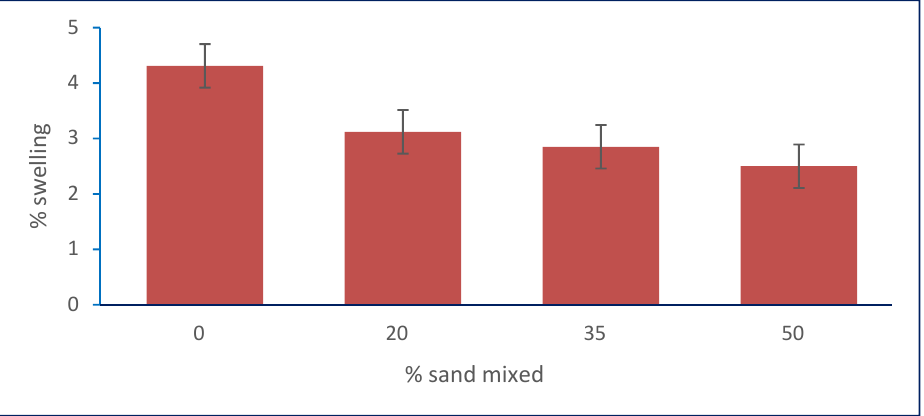
Figure 8. Effect of sand on swelling percentage.